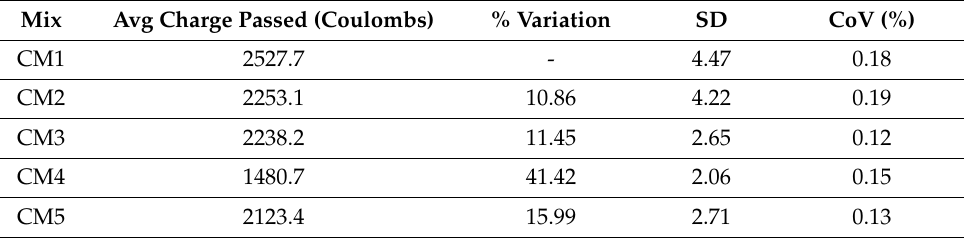
Table 5. Chloride ion penetration in CM-UFS-GO composites.